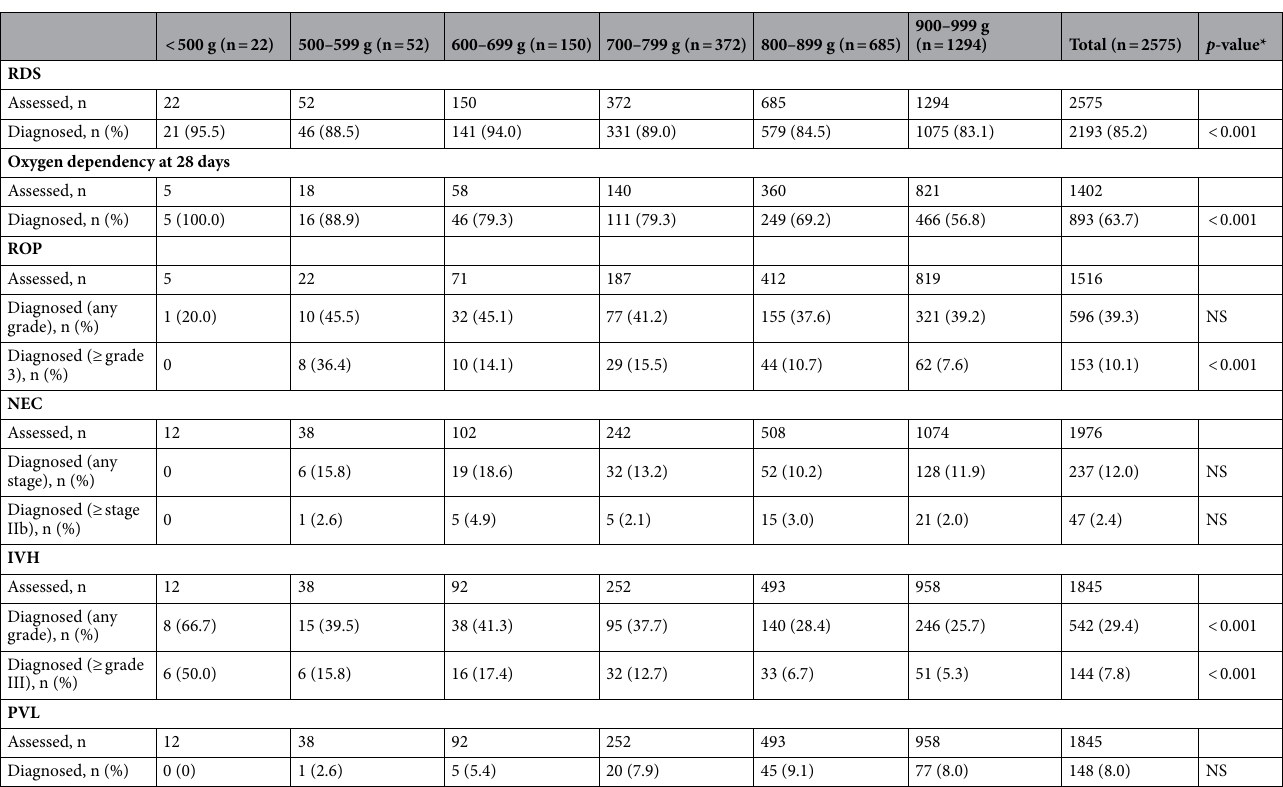
Table 6. The incidence of complications during hospitalization in ELBW infants. RDS, respiratory distress syndrome; ROP, retinopathy of prematurity; NEC, necrotizing enterocolitis; IVH, intraventricular hemorrhage; PVL, periventricular leukomalacia; NS, no significant difference. *Chi-square test linear-by-linear association were used to compare the groups of 500–599 g, 600–699 g, 700–799 g, 800–899 g and 900–999 g.